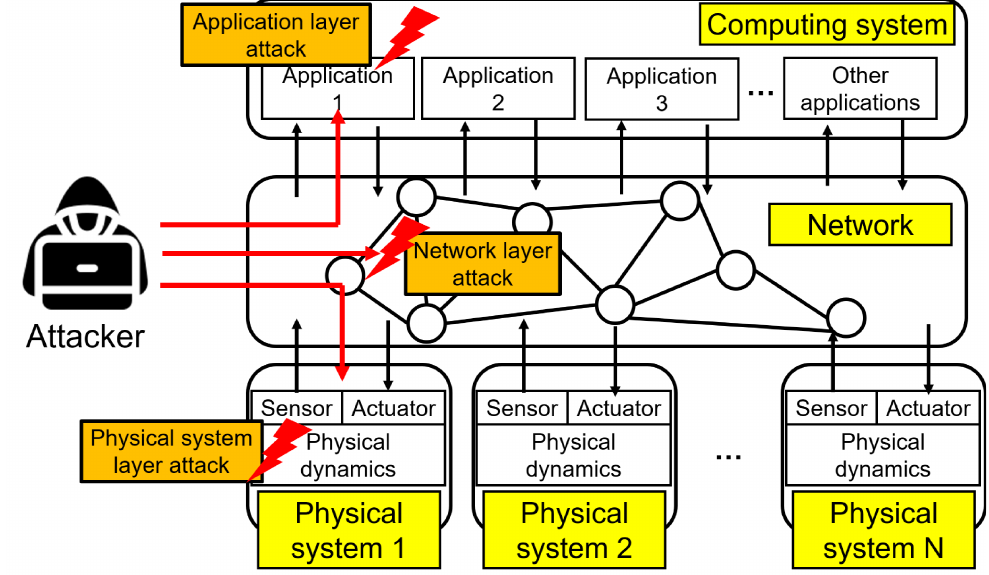
Figure 2. Cyber-physical attacks in hierarchical CPS